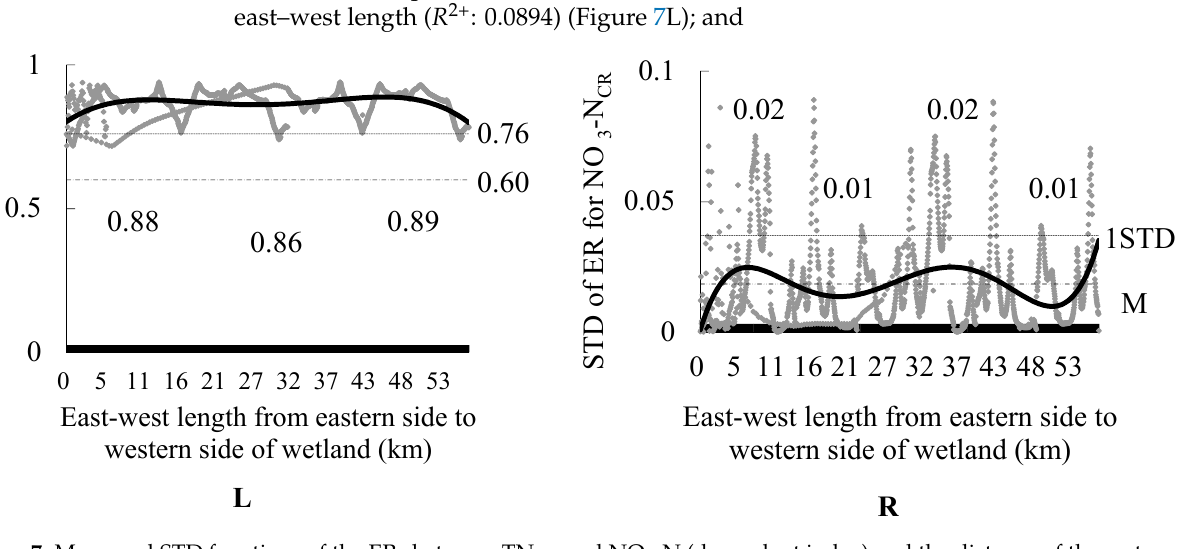
Figure 7. Mean and STD functions of the ERs between TN CR and NO 3 -N (dependent index) and the distance of the water inlet (independent index) during the gradual buffer extrapolation, based on the water inlet as a start line in the Sanhuanpao wetland. The curve on the left ( L ) is the mean of the ERs between TN CR and NH 4 -N, the curve on the right ( R ) is the STD of the ERs between TN CR and NO 3 -N, and the numbers in the figure are the maximum and minimum values of the fitting